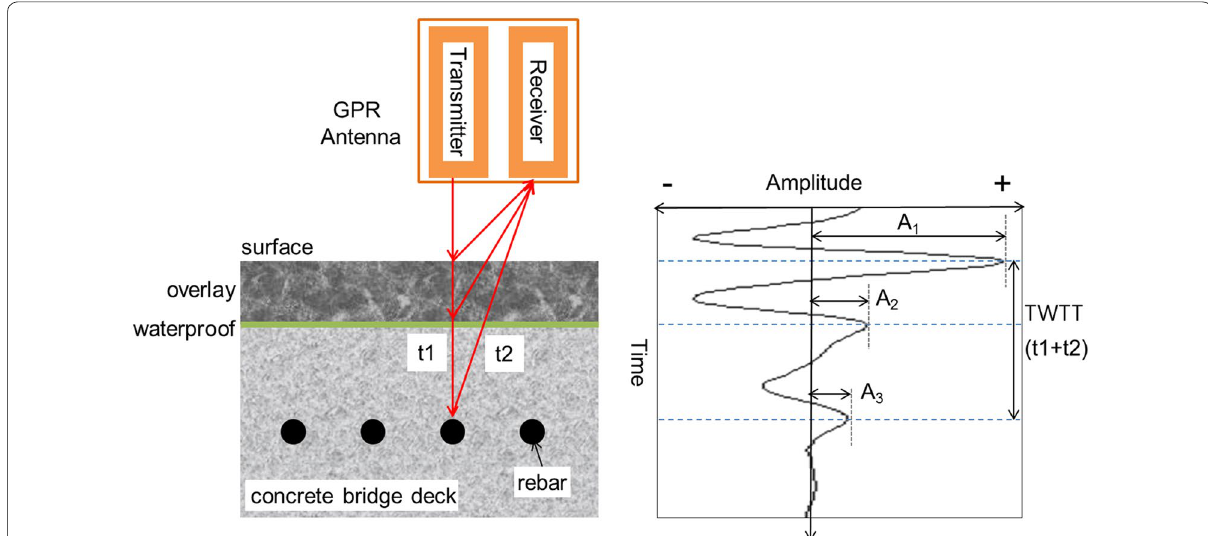
Fig. 1 Illustration of GPR scanning on a concrete bridge deck and a possible path of EM waves in asphalt‑covered concrete bridge